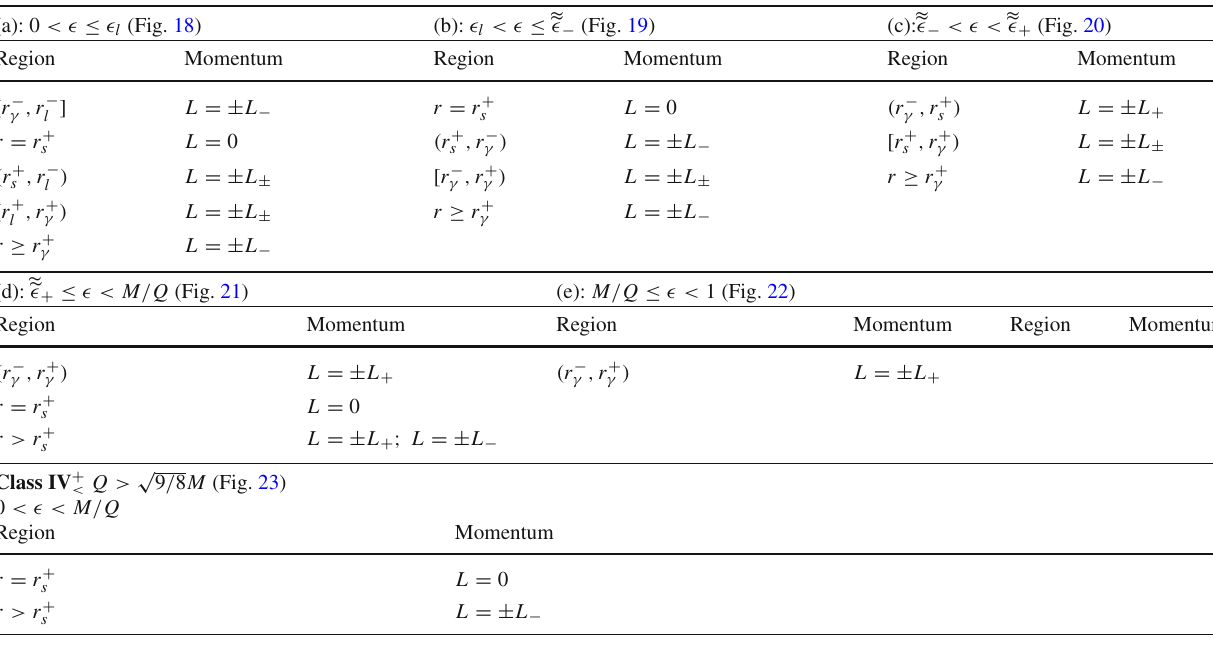
Table 7 Class III + < : ( 3